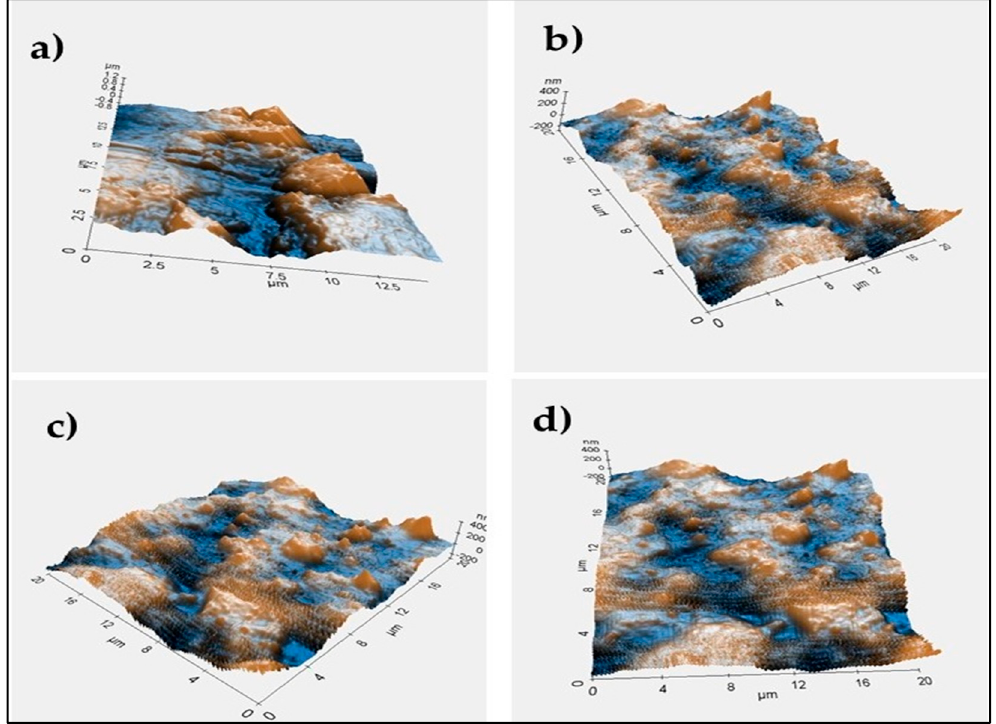
Figure 5. Atomic force microscopy of the ( a ) neat CA; ( b ) CA–PU15; ( c ) CA–PU30, and ( d ) CA–PU45.